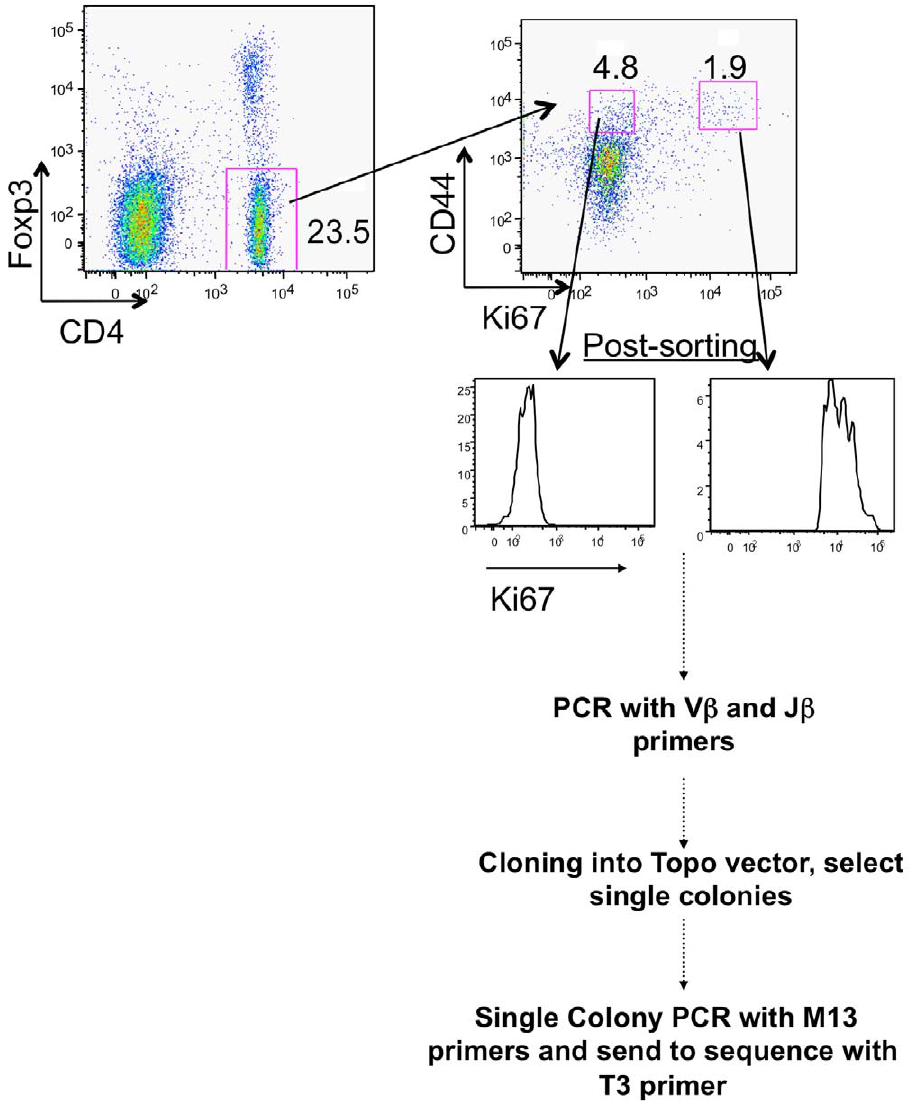
Figure 6. Sequence diversity among proliferating and nonproliferating V b 2-J b 1.1 and V b 4-J b 1.1 CD44 + , Foxp3 2 cells CD4 T cells (1) . Experimental approach to analyze the CDR3 sequences of V b 2-J b 1.1 and V b 4-J b 1.1 CD4 + CD44 + Foxp3 2 , KI-67 bright and Ki-67 negative cells from individual mice. Cells were FACS sorted into lysate buffer containing proteinase K. One-third of the lysate was subjected to PCR with specific V b and J b 1.1 primers (see Methods). PCR products were cloned into the Topo vector followed by bacterial transformation and single colony isolation. PCR with universal M13 primers were used on each colony to amplify the V b 2-J b 1.1 and V b 4-J b 1.1 gene segments followed by sequencing with the universal T3